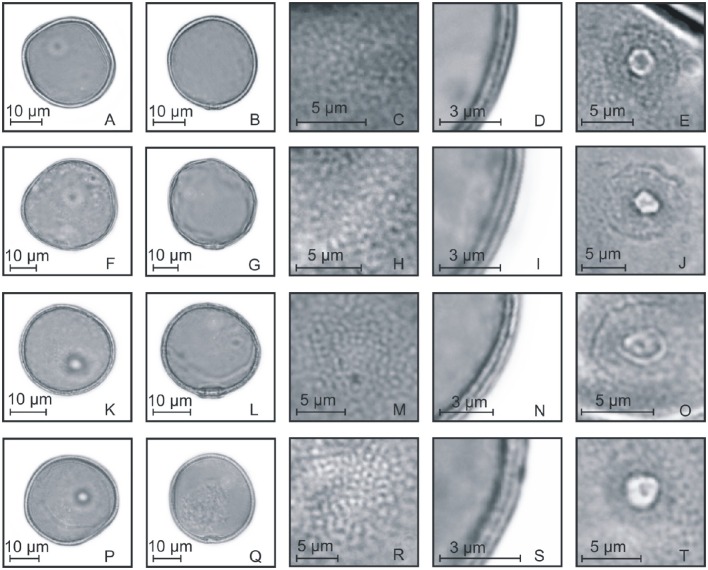
Pollen grains of the subfamilies Pooideae and Panicoideae. (A–E)
Melica sp.: PV (A), EV (B), detail of ornamentation (C), detail of the thickness of the exine (D), and detail of the aperture (E); (F–J)
Hordeum stenostachys: PV (F), EV (G), detail of ornamentation (H), detail of the thickness of the exine (I), and detail of the aperture (J); (K–O)
Piptochaetium montevidense: PV (K), EV (L), detail of ornamentation (M), detail of the thickness of the exine (N), and detail of the aperture (O); (P–T)
Paspalum urvillei: PV (P), EV (Q), detail of ornamentation (R), detail of the thickness of the exine (S), and detail of the aperture (T).